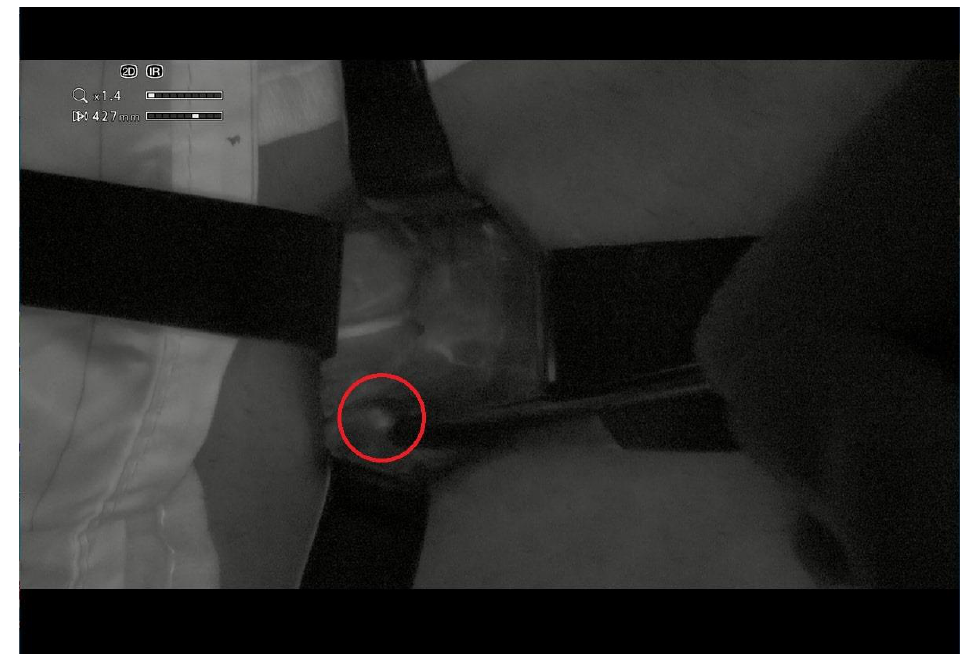
Figure 4. Use of NIR and ICG for visualization of the upper parathyroid (red circle).